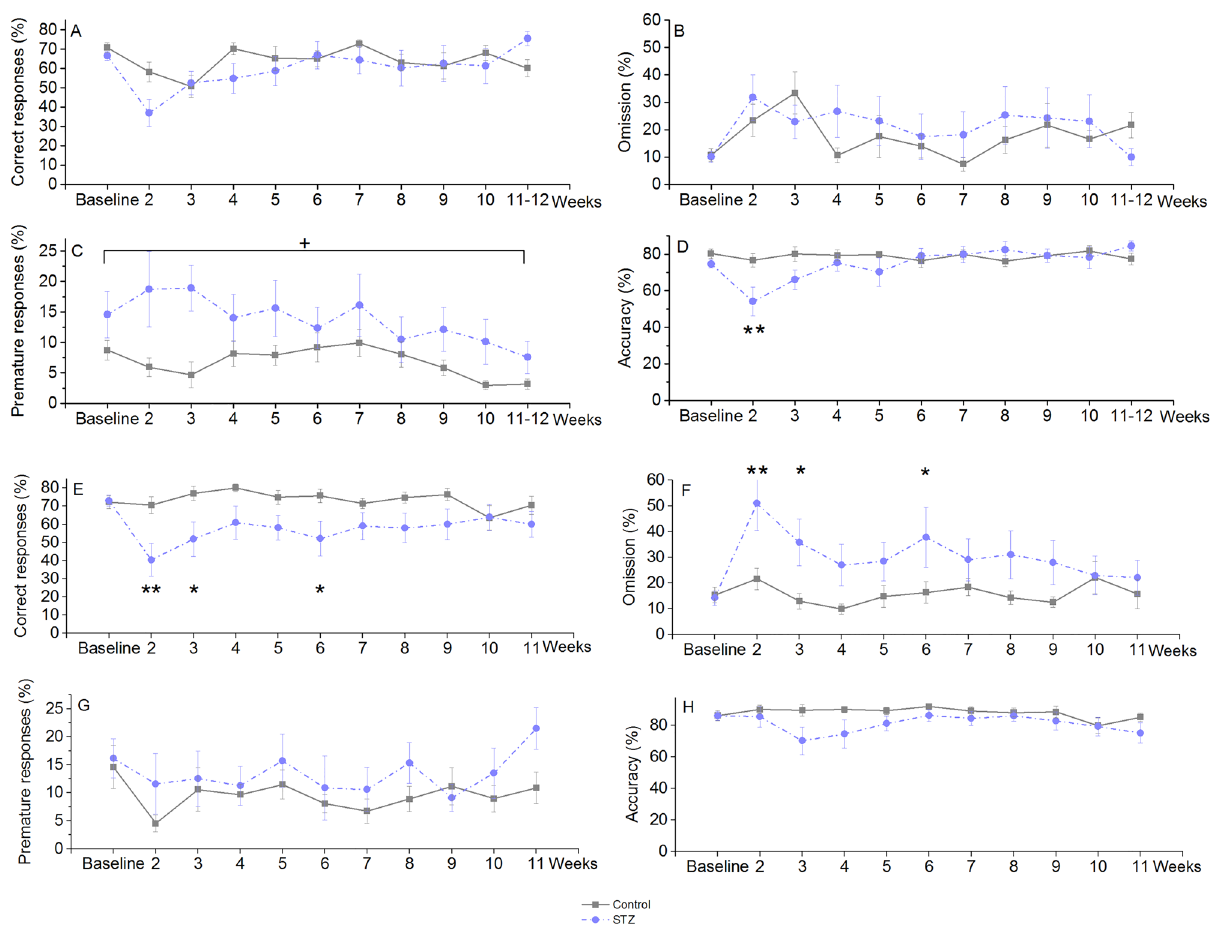
Figure 3. Learning performance of icv. STZ-injected (‘STZ’) and vehicle-treated (‘control’) rats in the 5CSRTT at various time points post-injection. Means ± SEM values are shown. ( A , B , C , D ) Results of old animals. + : p = 0.023 significant treatment effect in percentage of premature responses (F(1, 21) = 5.98). **: p < 0.01 significant difference vs control on the same day (post-hoc Duncan test following repeated measures ANOVA with significant Day × treatment interaction: F(10, 200) = 2.53, p = 0.007) for percentage of accuracy. ( E , F , G , H ) Results of young animals. *, **: p < 0.05, p < 0.01 significant difference between groups on the same day (post-hoc Duncan test following repeated measures ANOVA with significant Day × treatment interaction: F(10, 220) = 2.20, p = 0.019 for percentage of correct responses and F(10,220) = 2.06, p = 0.029 for omissions). Group size of old STZ-treated rats: n = 12 at Week 2, n = 11 at Week 3–9, n = 10 at Week 10, n = 8 at Week